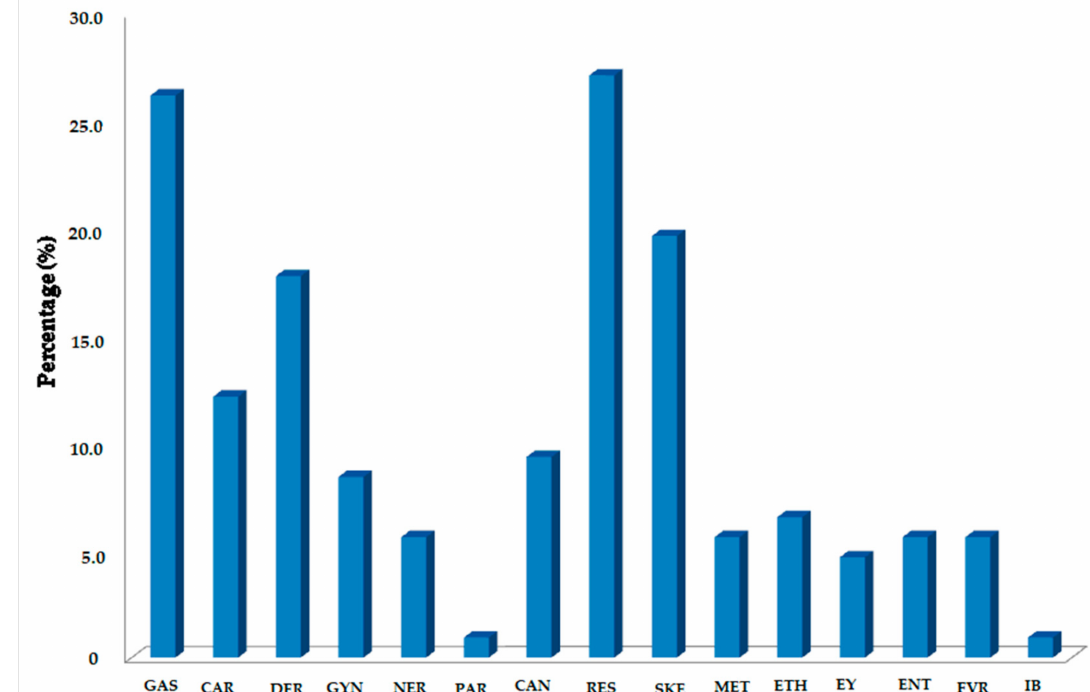
Figure 9. Percentage of plants used in different disease groups. Abbreviation: GAS: Gastrointestinal problems, CAR: Cardiovas- cular problems, DER: Dermatological disorders, GYN: Gynecological problems, NER: Nervous system disorders, PAR: Parasitic problems, CAN: Cancer, RES: Respiratory complaints, SKE: Skeleto-muscular system disorder, MET: Metabolic syndromes, ETH: Ethnoveterinary ailments, EY: Energy yielding, ENT: Eyes, Ears and Nose problems, FVR: Fever, IB: Insect